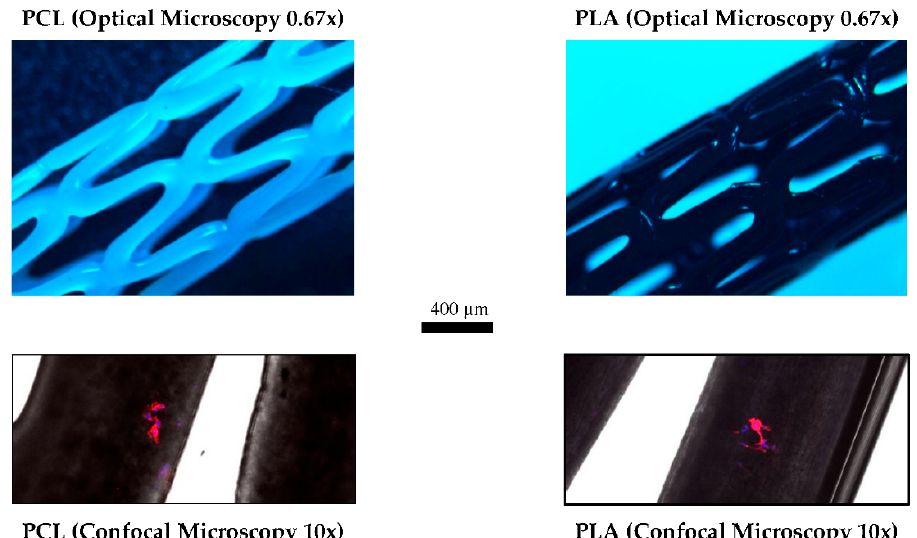
Figure 5. Confocal Laser Microscopy Images: ( Left ) PCL stent; ( Right ) PLA stent. Samples cultured with 3T3 fibroblast cells. Nucleus was stained with DAPI (blue) and actin cytoskeleton was stained with rhodamine-phalloidin (red).